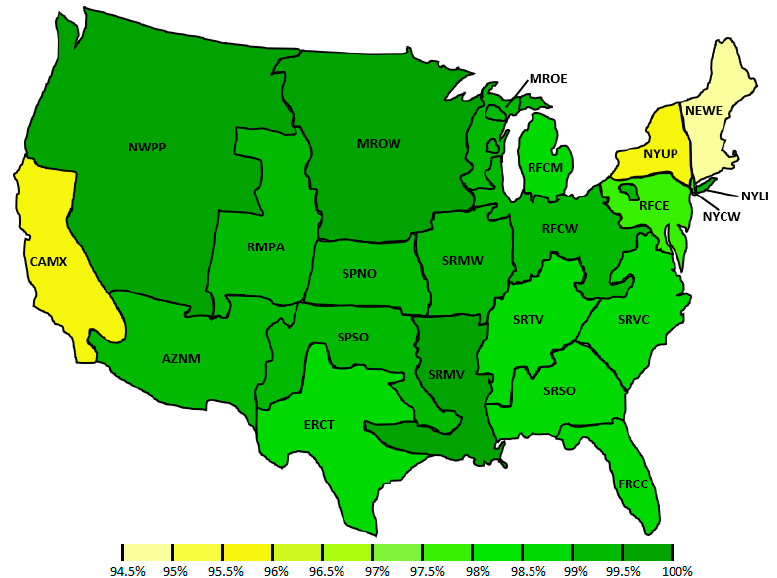
plant in all eGRID subregions.